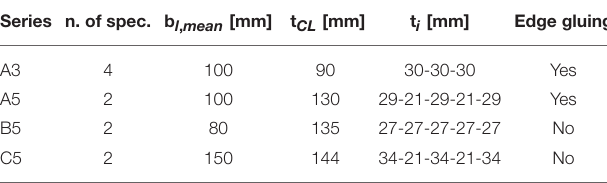
TABLE 1 | Characteristics of tested CLT